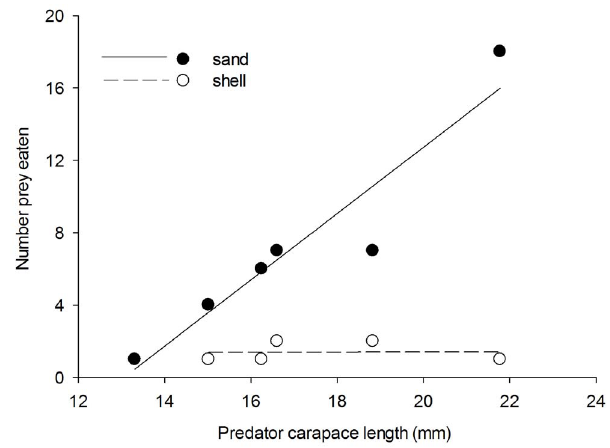
Figure 3. The number of prey crabs eaten as a function of predator size (carapace length) in sand (closed circles) and shell (open circles) habitat. Lines represent linear regression. Equations are: 1) sand: prey eaten= 2 23.926 + (1.883 6 carapace length), R 2 =0.895; and, 2) shell: prey eaten =1.373 + (0.00155 6 carapace length), R 2 =0.0000568.